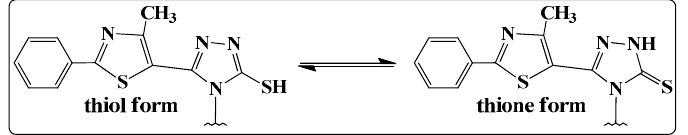
Figure 1. Thiol-thione tautomerism shown by the synthesized Schiff bases.